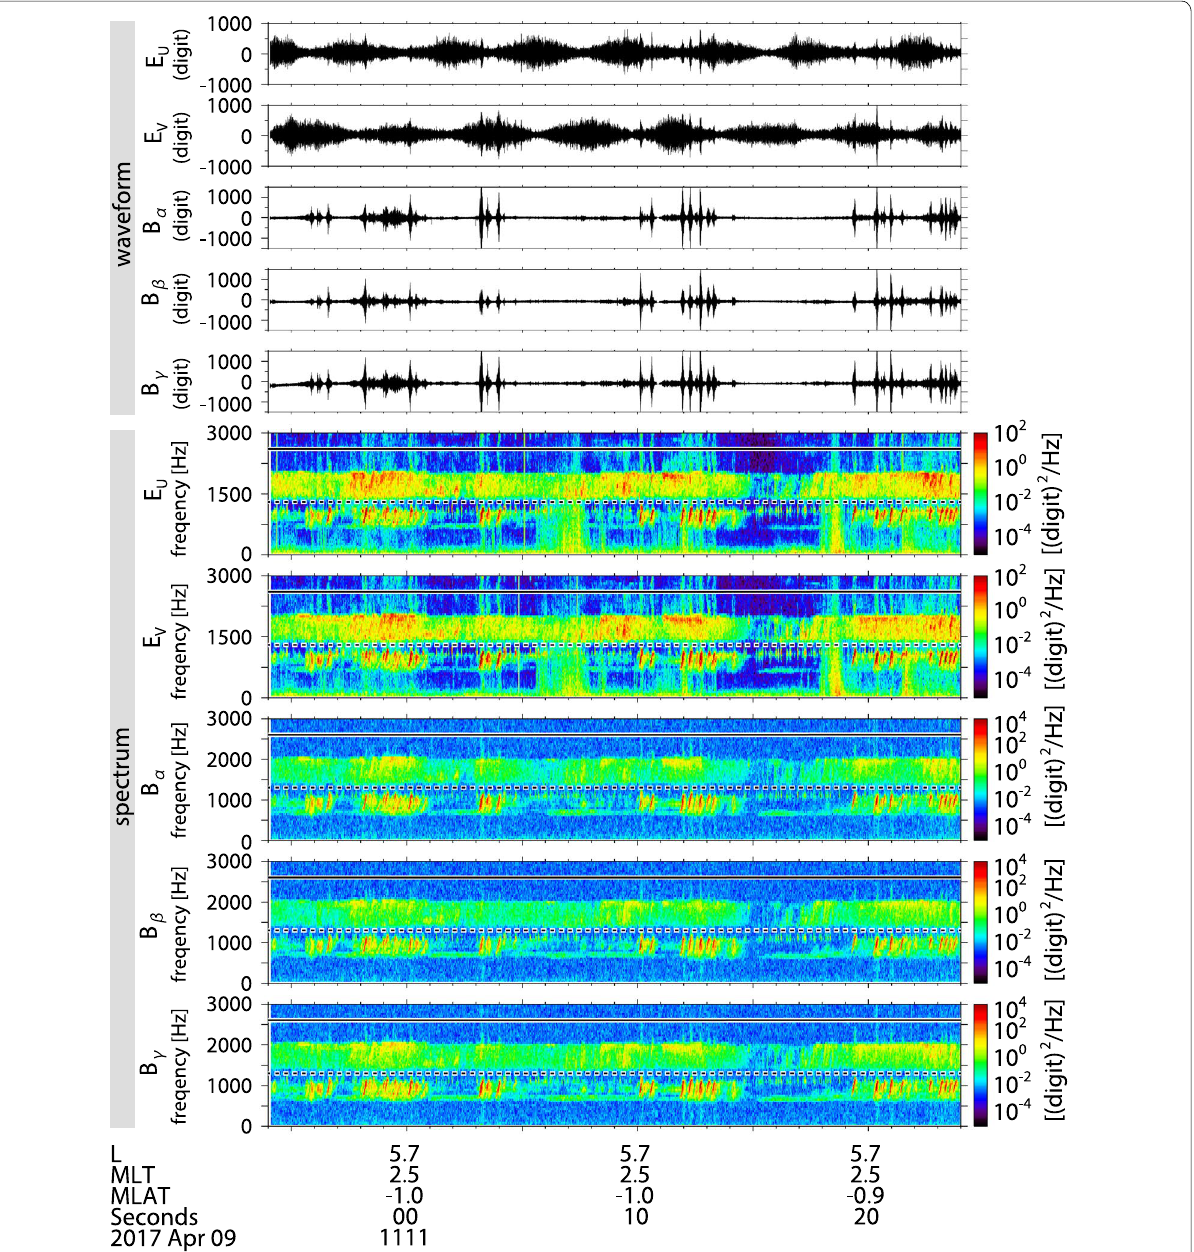
Fig. 19 A sample result of waveform observation by the PWE/WFC in chorus burst mode from 11:10:54 to 11:11:24 UT on April 9,